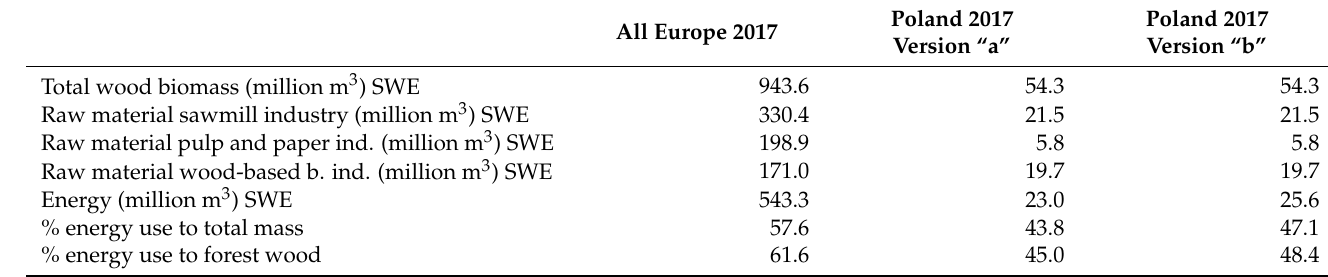
Table 3. Primary division and wood processing: summary of